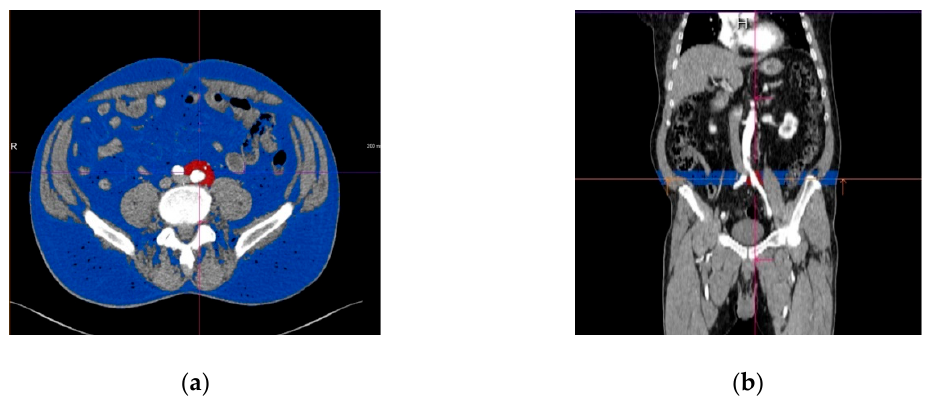
Figure 2. Perivascular adipose tissue surrounding left common iliac artery (marked in red color). ( a ) Transverse section; ( b ) longitudinal section, with the region of interest immediately after the origin of the iliac arteries from the aorta. The subcutaneous adipose tissue is represented in blue.